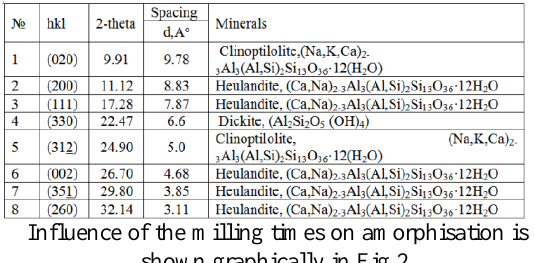
Influence of the milling times on amorphisation is shown graphically in Fig.2.